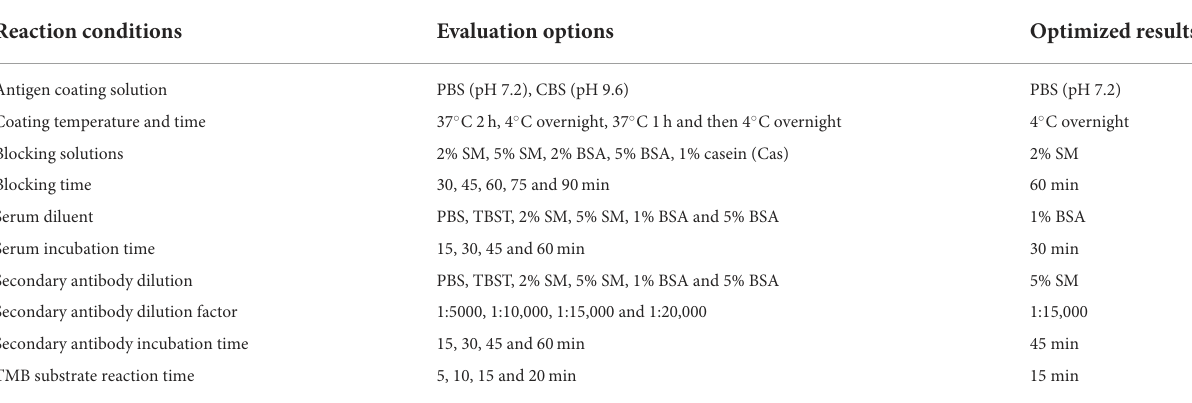
TABLE 2 Optimized conditions of the